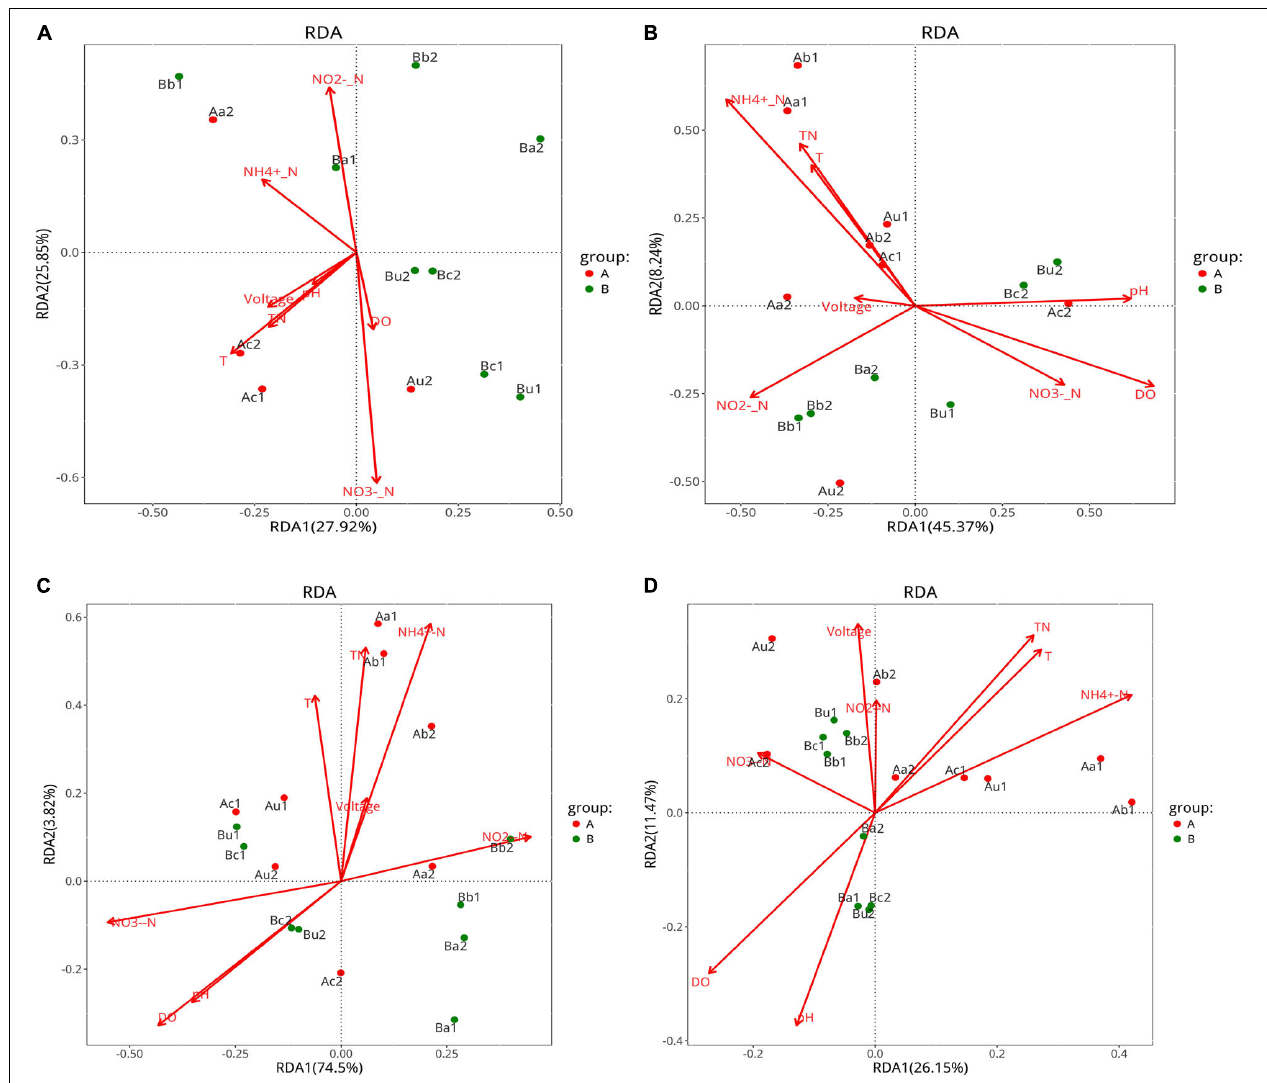
FIGURE 7 | RDA analysis curves of panels AOA (A) , AOB (B) , NOB (C) , and 16S rRNA V4-V5 region (D) . Symbols indicate the samples and arrows represent environmental variables. Group A represents Device A operated with a C/N ratio = 10:1, and Group B represents Device B operated with a C/N ratio = 5:1. Environmental variables were chosen based on the significance determined from individual RDA